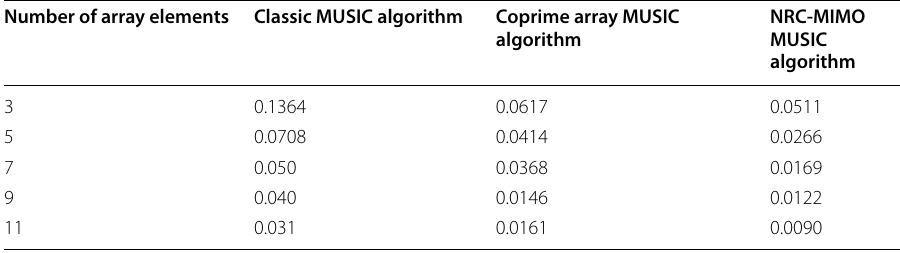
Table 5 RMSE values under different numbers of array elements Number of array elements Classic MUSIC